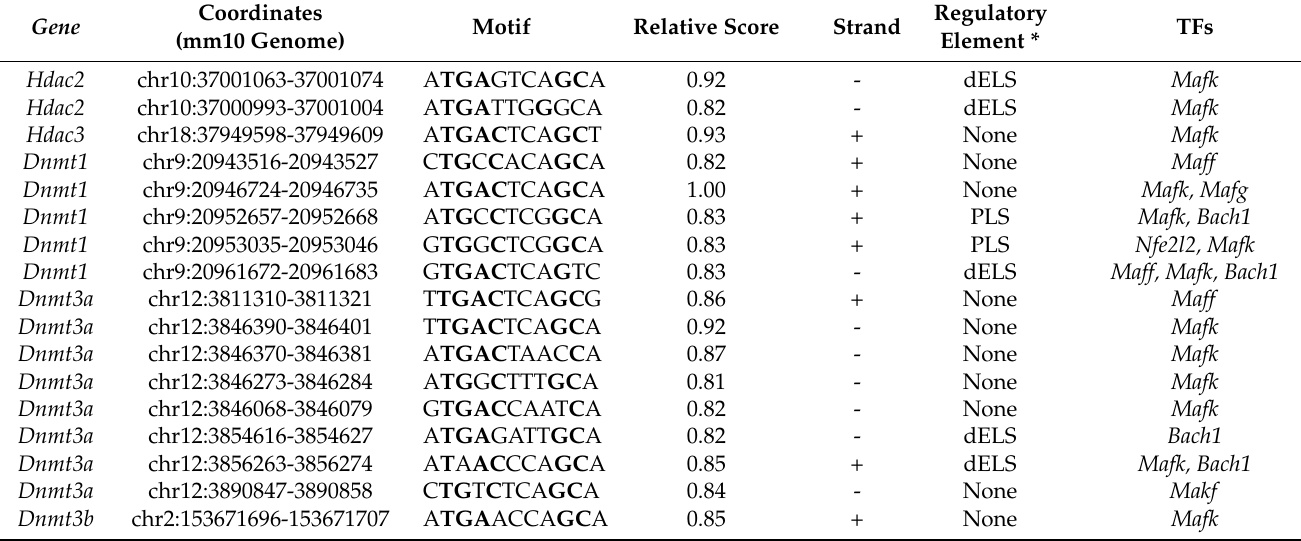
Table 2. Table showing the putative ARE sequences identified in the mouse genome with a relative score over 80% . Columns 1 and 2 describe the genes containing the transcription factor-binding sites and their specific locations according to the GRCm38 (mm10) mouse genome assembly. The Motif column contains the specific sequence that was identified as a putative ARE sequence. The TGA motif in nucleotides 2, 3, and 4 of the motifs and the GC motif in nucleotides 9 and 10 of the motif are in bold, if present. Relative scores were calculated against the consensus binding sequence according to the position frequency matrix of the JASPAR database. The strand column indicates in which strand of the DNA, relative to the transcript sense is the putative ARE sequence: sense (+) or antisense (-). The Regulatory Element column provides the segmentation annotation from the ENCODE Candidate Cis-Regulatory Elements (cCREs) combined from all cell types of Track at the UCSC Genome Browser. The TFs column indicates the transcription factor for which the ChIP-seq site belonged in the ChIP-Atlas database. *, PLS, promoter-like signature; dELS; distal enhancer-like signature.